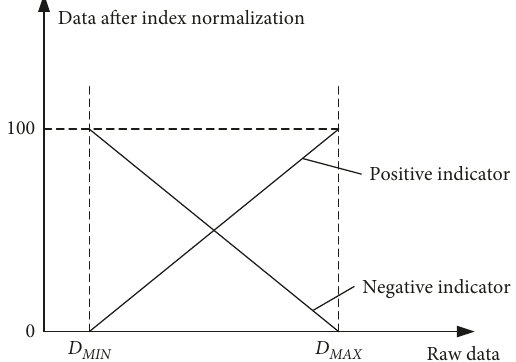
Figure 3: Schematic diagram of geometric representation results of index normalization.